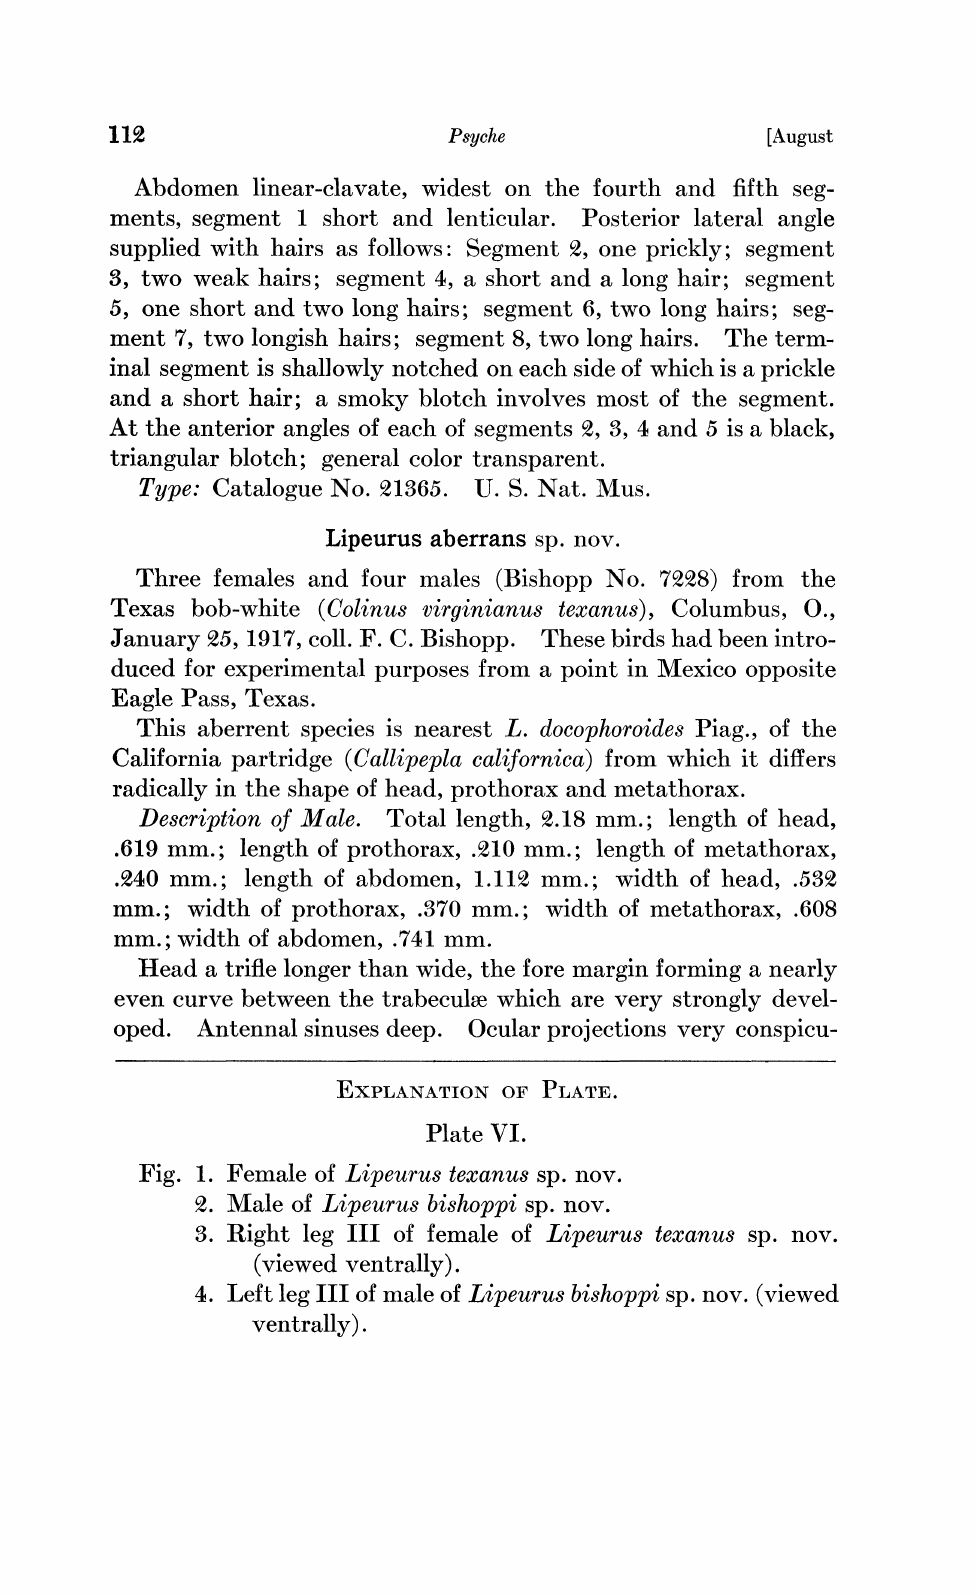
Fig. 1. Female of Lipeurus texanus sp. nov.